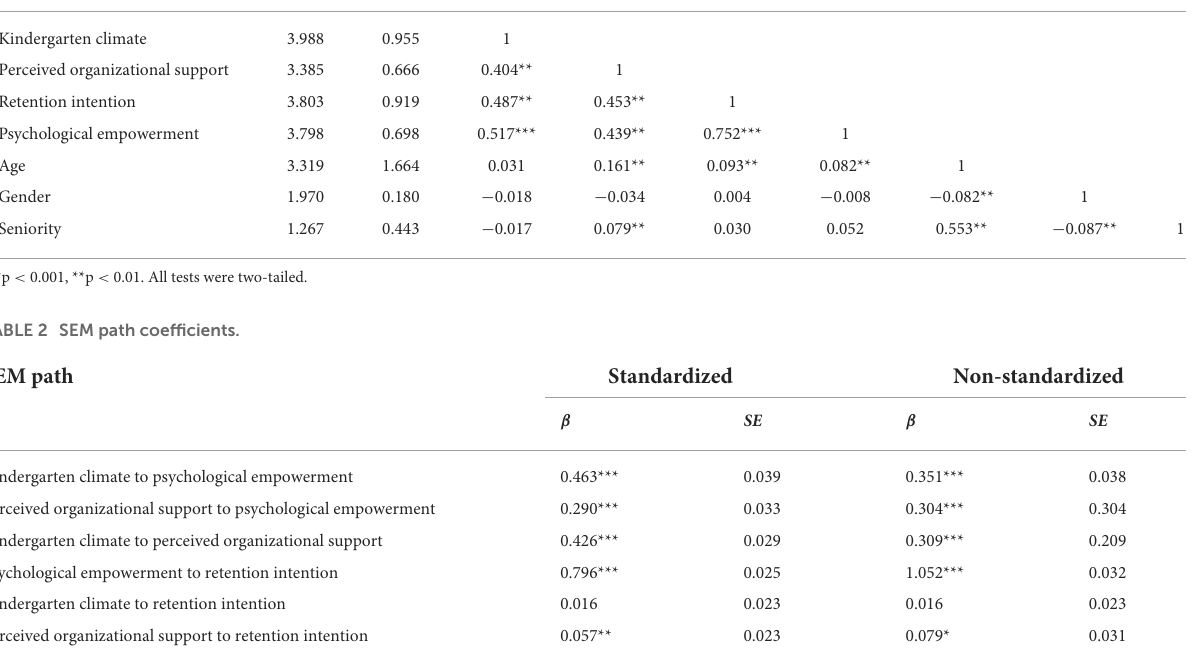
TABLE 1 Means, standard deviations, and correlations of the variables ( N = 1,199). Variables